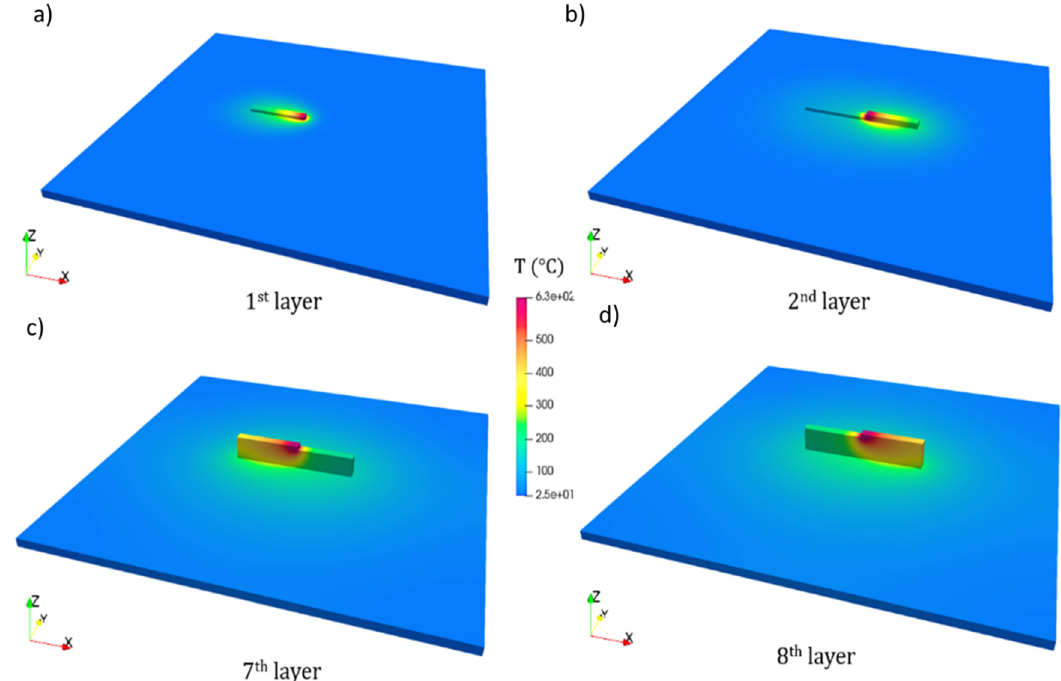
Fig. 6. Simulated temperature fi eld of Zigzag strategy at different layers: (a) 1st layer, (b) 2nd layer, (c) 7th layer, (d) 8th layer.